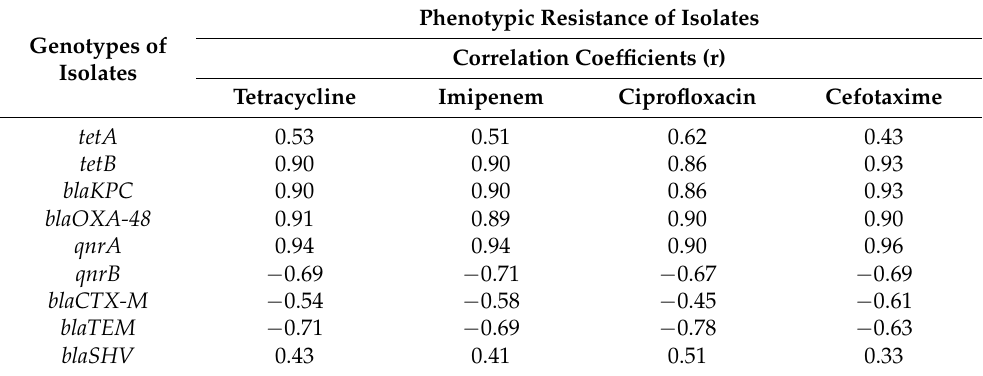
Table 3. Correlation between phenotypes and genotypes of MDR E. coli isolates.